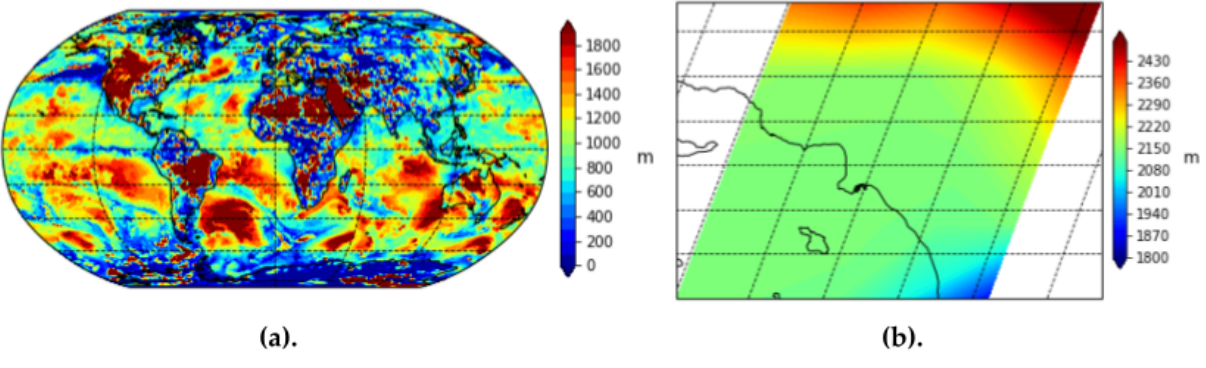
Figure 8. MERRA-2 PBL Height (in meters) visualization over various geographic scales, ( a ) Global, ( b ) Los Angeles.